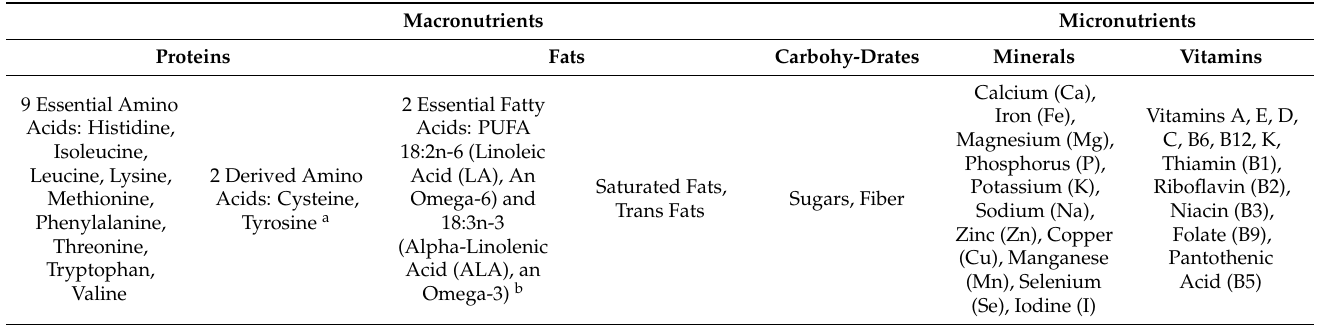
Table 2. Nutrients selected for analysis of foods and for which AIs, MRAIs and SRAIs were deter- mined (see Supplementary